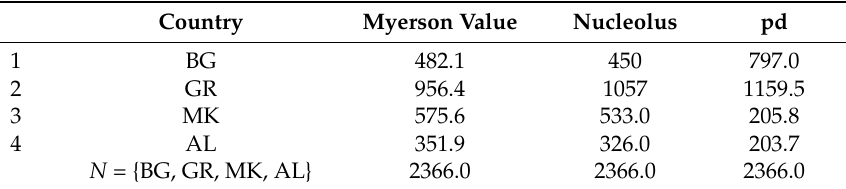
Table 5. Solutions for the 4-country game (in MW).